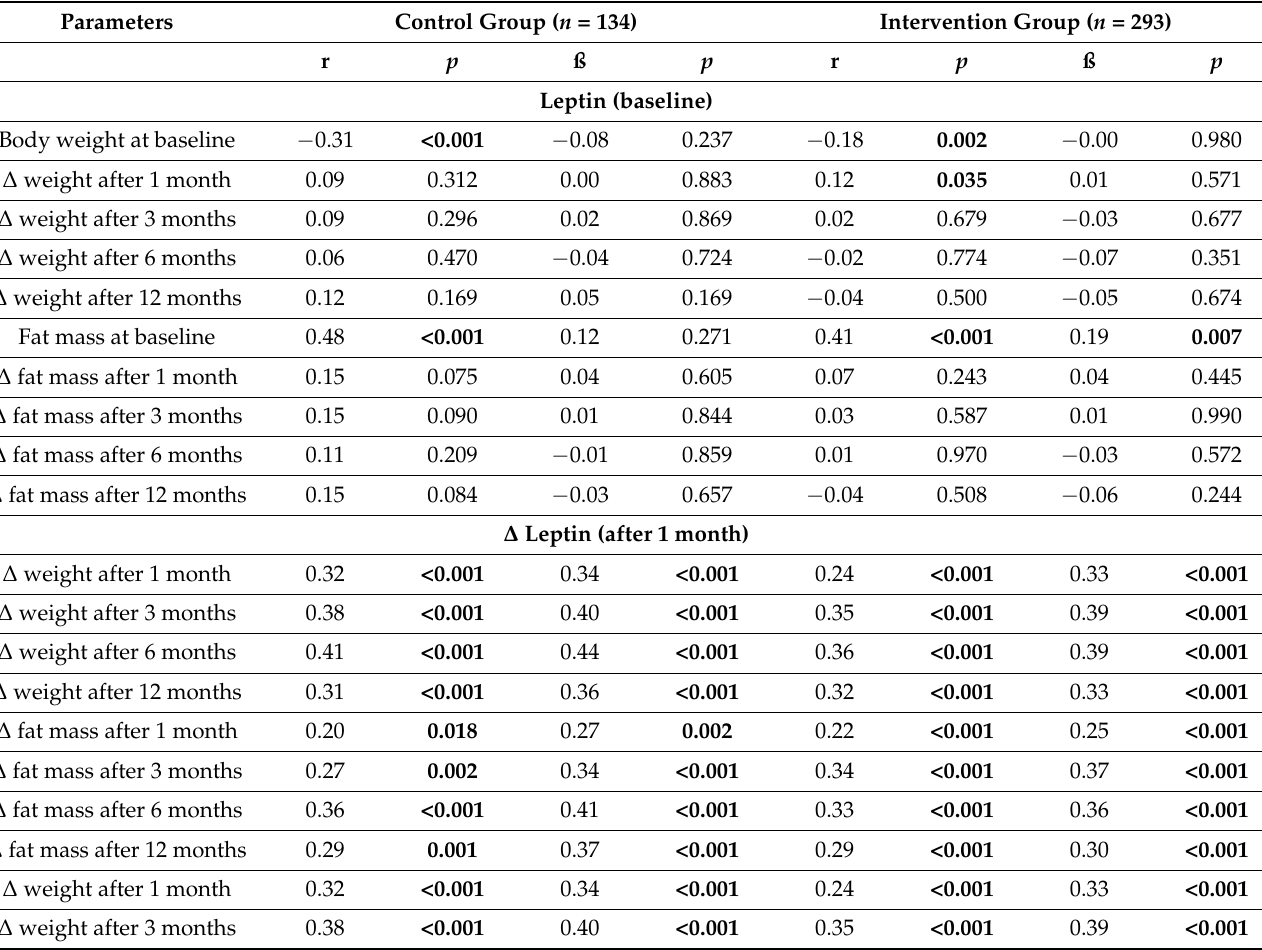
Table 3. Associations between leptin and weight or fat mass.